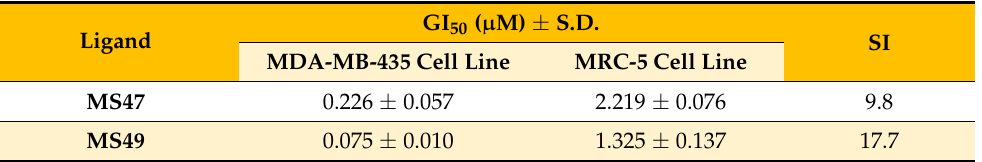
Table 2. Growth inhibition effects of MS47 and MS49 on human melanoma MDA-MB-435 and human normal lung MRC-5 cell lines. Values of GI 50 are presented as mean ± standard deviation of at least three separate experiments ( n = 8 per trial). “SI: Selectivity index (GI 50 MRC-5/GI 50 melanoma cell line)”.